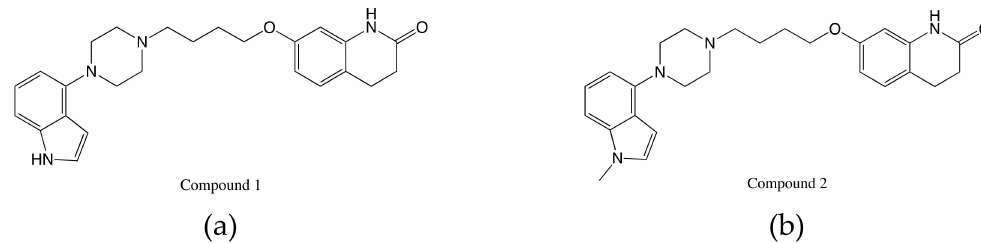
Figure 5. Structures of indole-aripiprazole hybrid compounds used to investigate D2R biased signaling: ( a ) Compound 1; ( b ) Compound 2